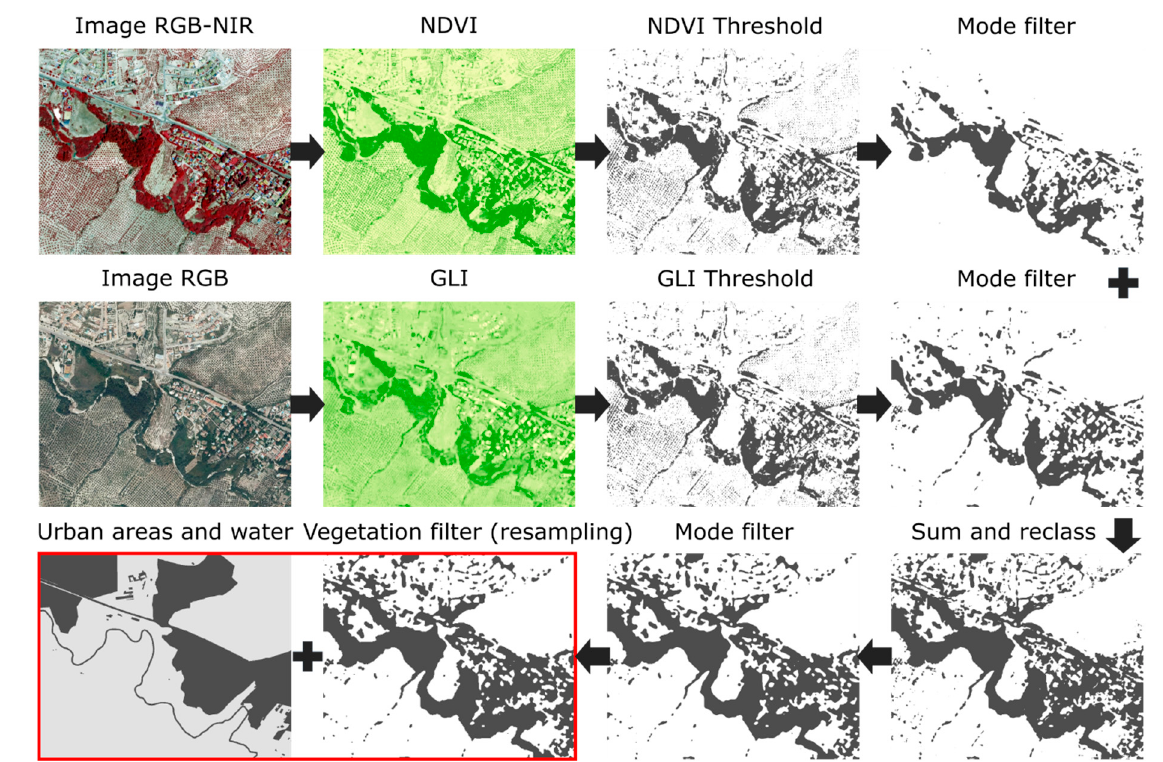
Figure 4. Detail of the process employed to obtain vegetation, urban and water filters. False color composition of image RGB–NIR is NIR–Red–Green. Final applied filters are highlighted in red.